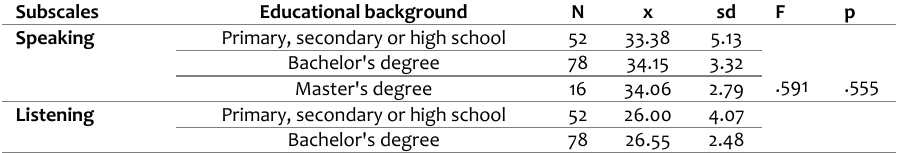
Table 4. The Parent-Child Communication Assessment Tool (PCCAT) ANOVA Test Results regarding the Subscale Scores for the Educational Background of the